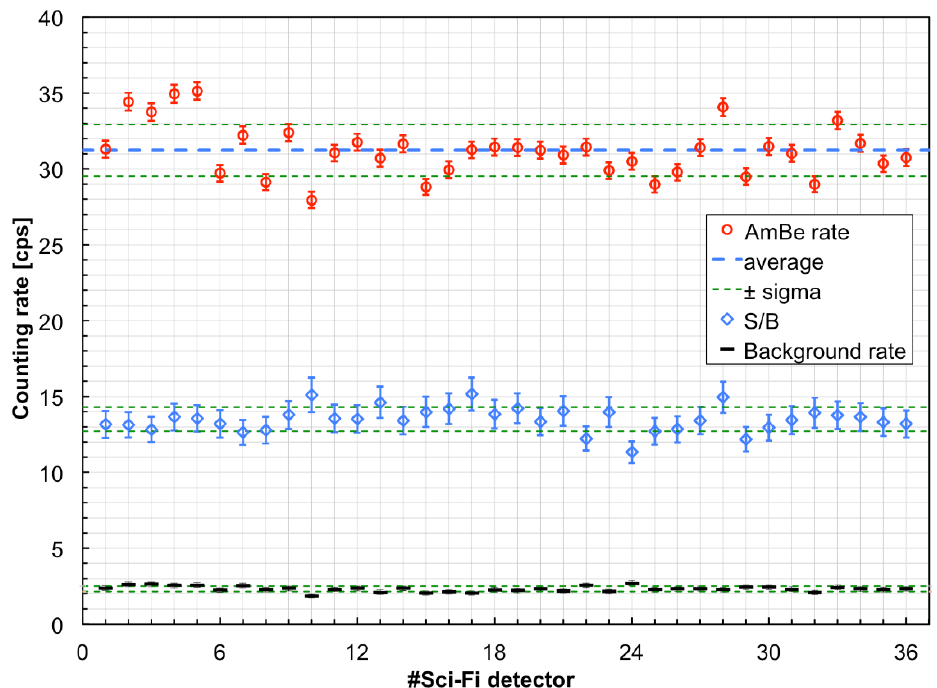
Figure 17. The counting rate of the 36 SciFi detectors, measured on top of the AmBe source in 100 s, along with the background rate and the signal-to-background ratio. The error bars represent the statistical uncertainty, the green dashed lines indicate ± 1 standard deviations from the average.